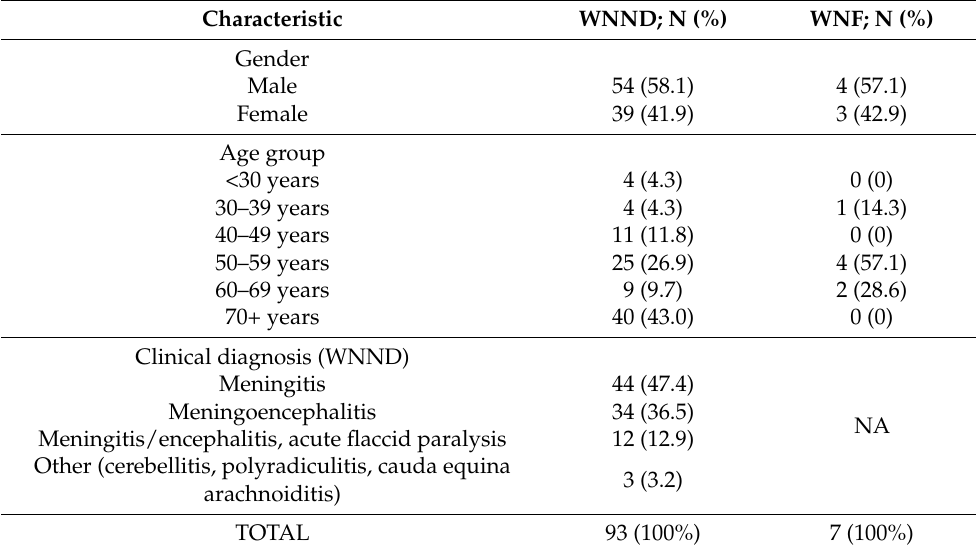
Table 2. Demographic and clinical characteristics of human WNV